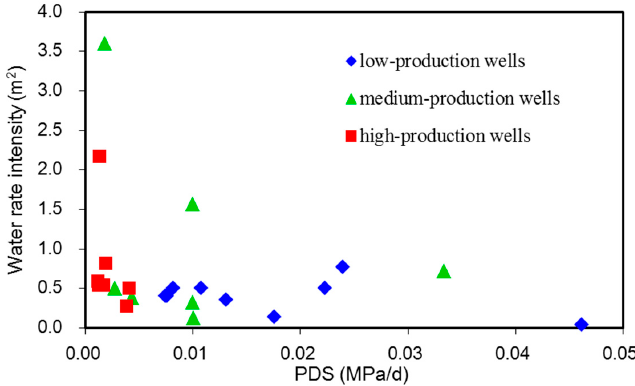
Figure 12. The relation between water rate intensity and PDS in water drainage stage.